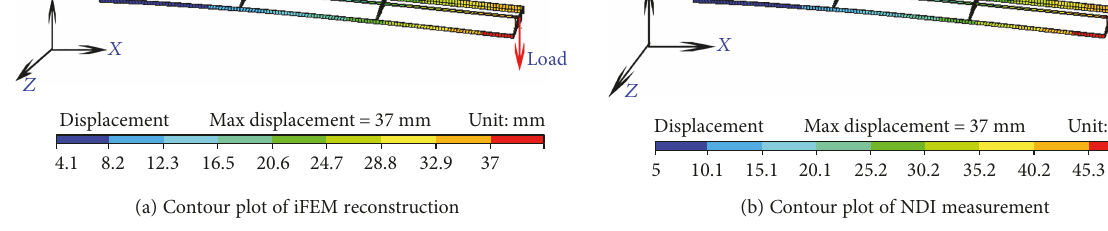
Figure 8: Comparison of iFEM reconstruction for a frame to NDI